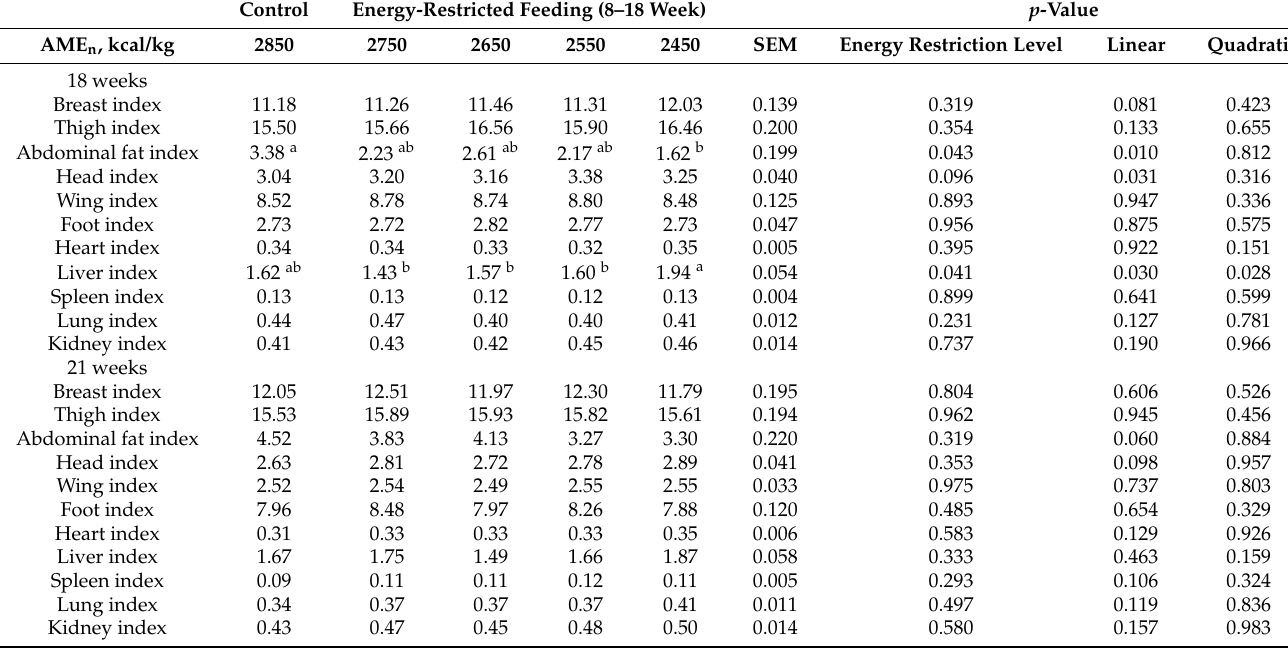
Table 6. Effects of energy-restricted feeding and switching to ad libitum feeding on carcass and visceral organ development (%) of the pullets at 18 and 21 weeks of age. 1. Control